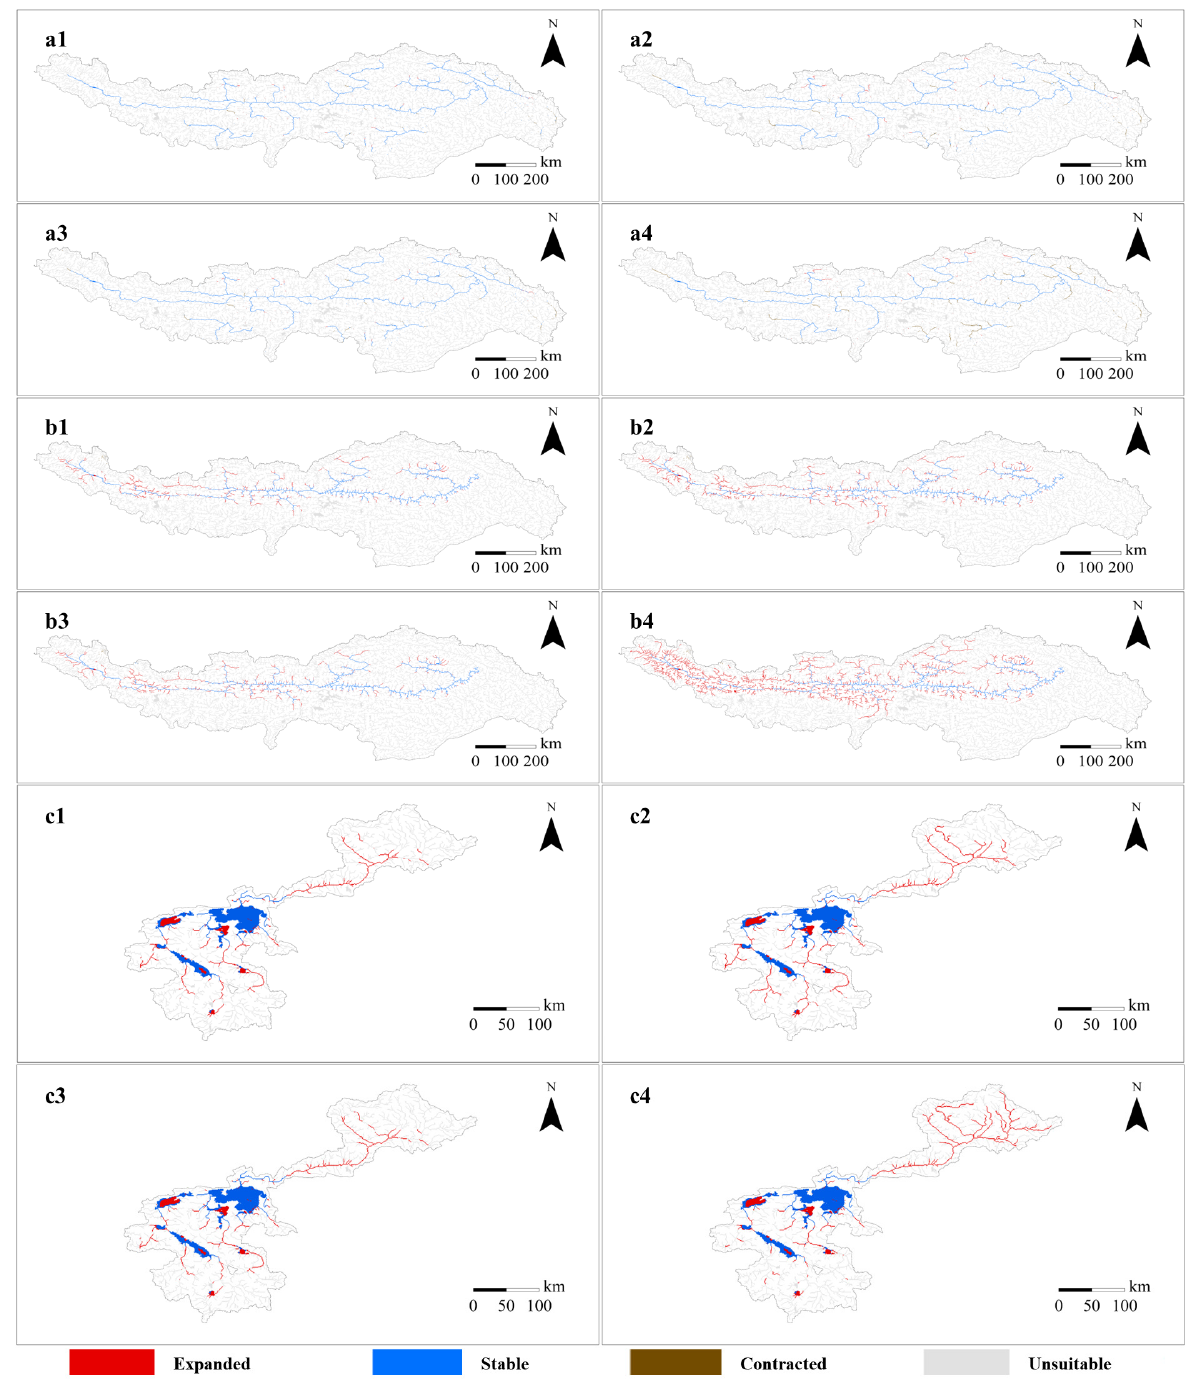
Figure 3. Changes in potential suitable habitats of three fish species under four scenarios. ( a : Glyp- tosternon maculatum ; b : Oxygymnocypris stewart ii; c : Gymno cypris selincuoensis ; 1 : 2050-RCP2.6; 2 : 2050-RCP8.5; 3 : 2090-RCP2.6; 4 :